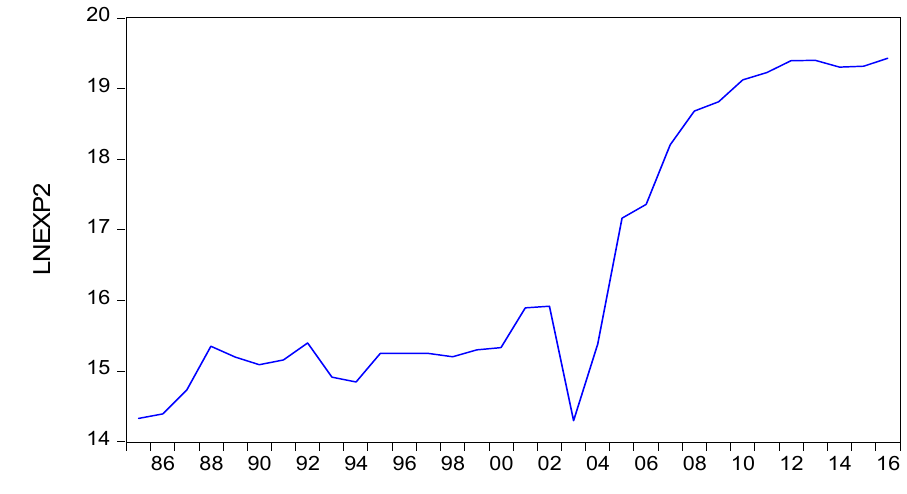
Figure 3. Trends in Lnexp in Ethiopia, 1985–2016.